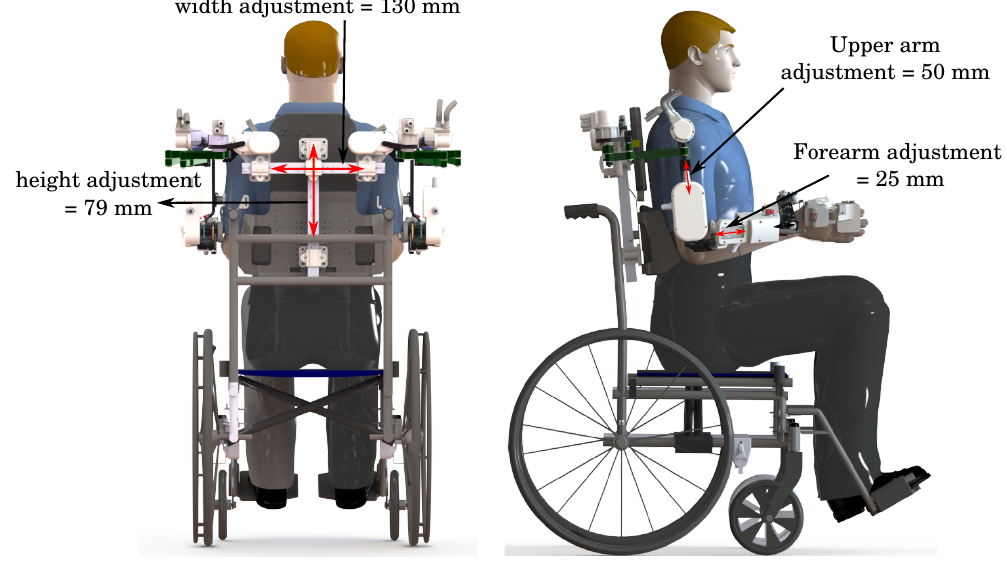
Figure 4. Passive adjustments in back, shoulder, upperarm and forearm for R ECUPERA